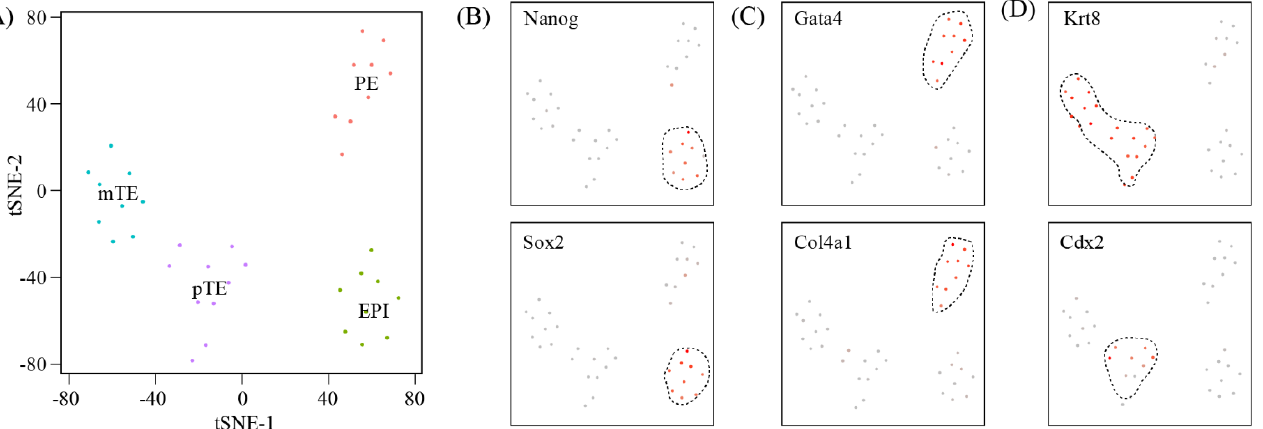
Figure 4. A single-cell atlas of E4.5 embryos: ( A ) TSNE clustering of single cells from mouse E4.5 blastocysts which were collected from GD5 uteri from a previous study. EPI: epiblast; PE: primitive endoderm; mTE: mural trophectoderm; pTE: polar trophectoderm. ( B – D ) TSNE plots showing the expression pattern of canonical marker genes for EPI ( B ), PE ( C ) and mTE/pTE ( D ). Dashed lines show the boundaries of the specific cell clusters.